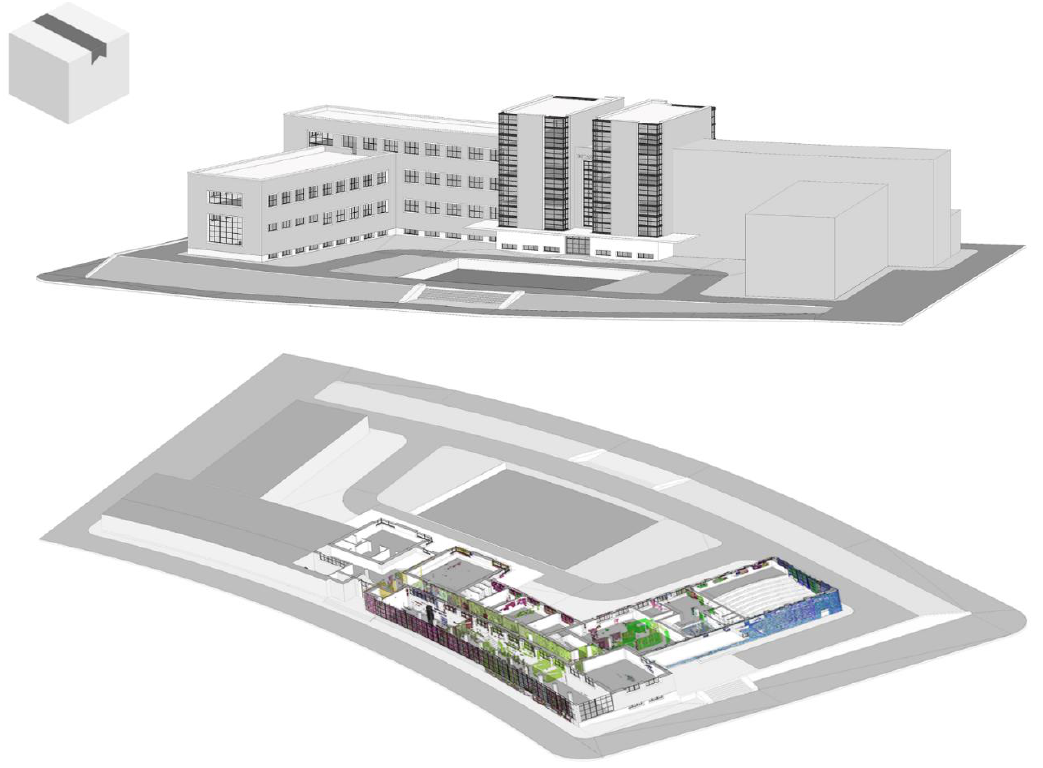
Figure 10. The Botany Institute. “White box”